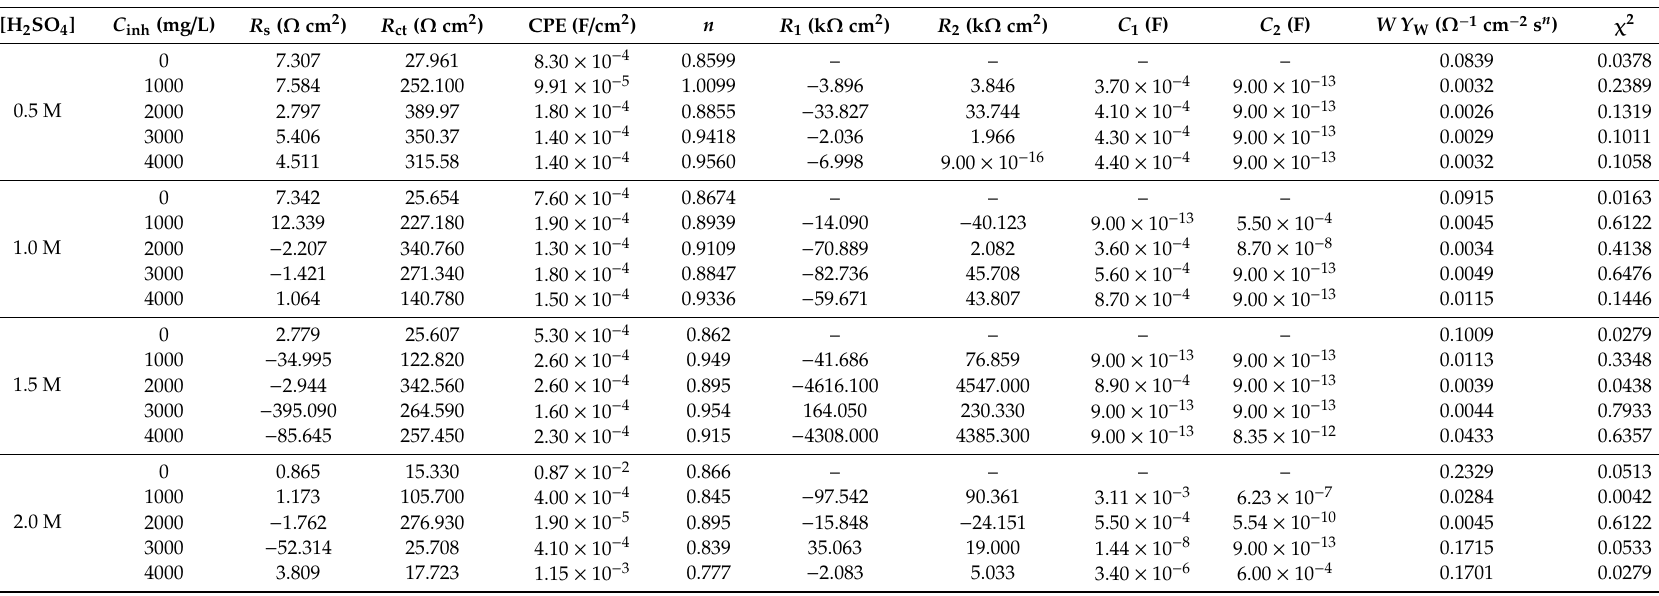
Table 3. Fitting results of electrochemical impedance spectroscopy (EIS) data for 304 SS in several H 2 SO 4 concentration with and without